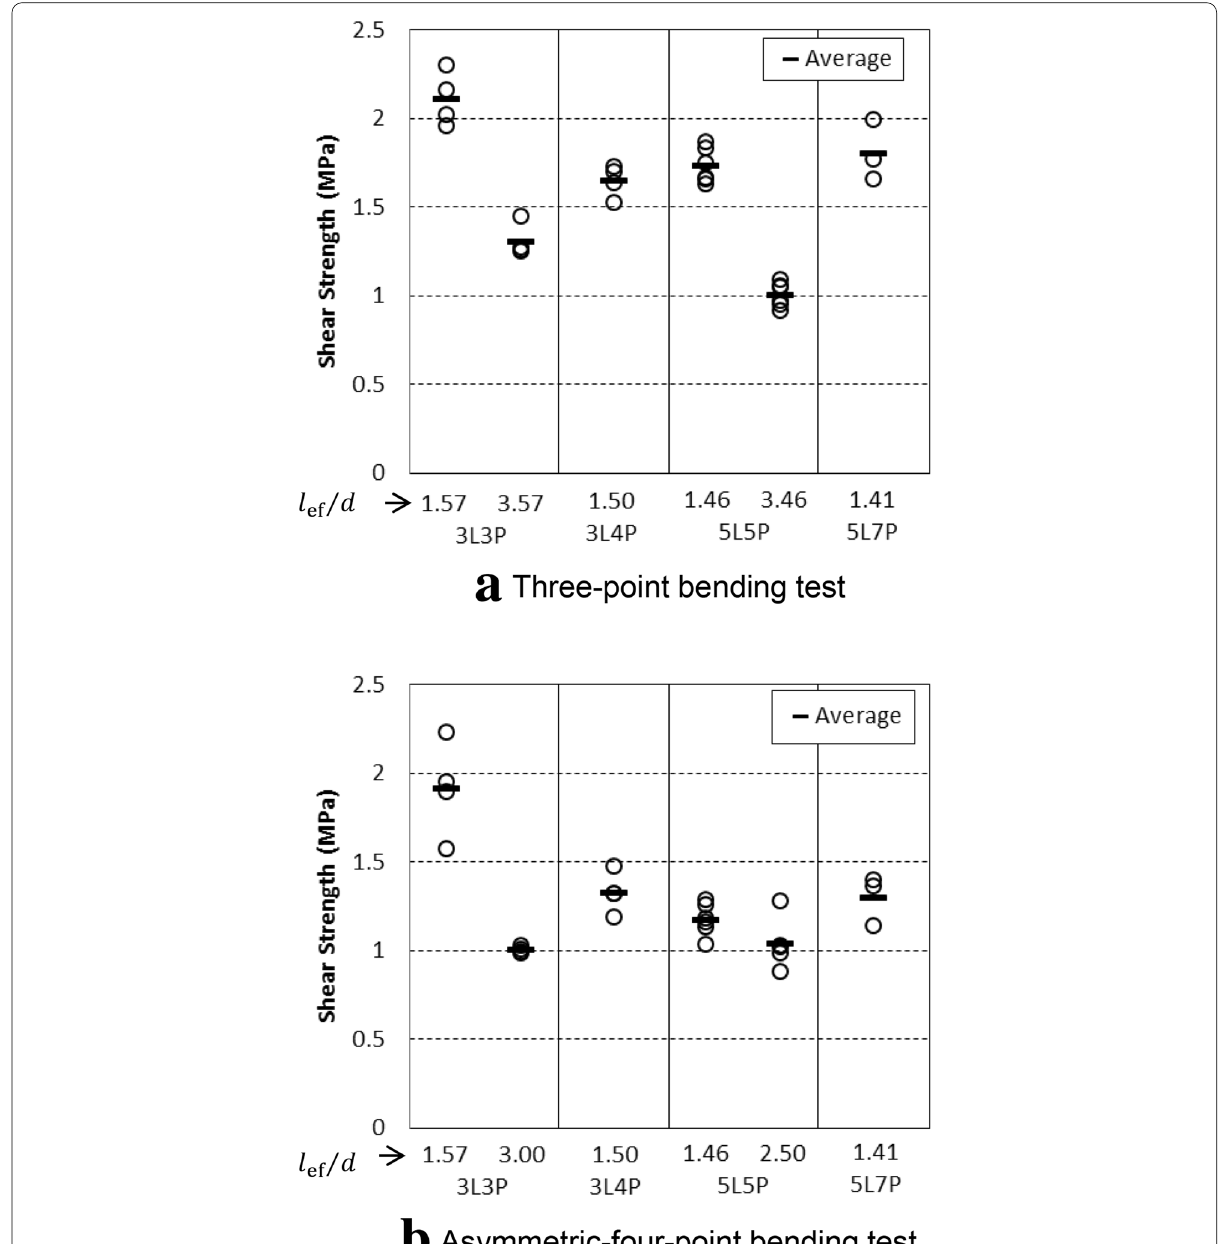
Fig. 5 Nominal shear